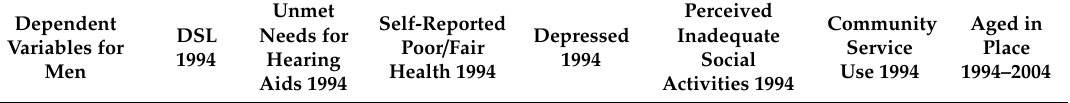
Table 9. Multivariate regression results on DSL prevalence and its associated outcomes, 1994